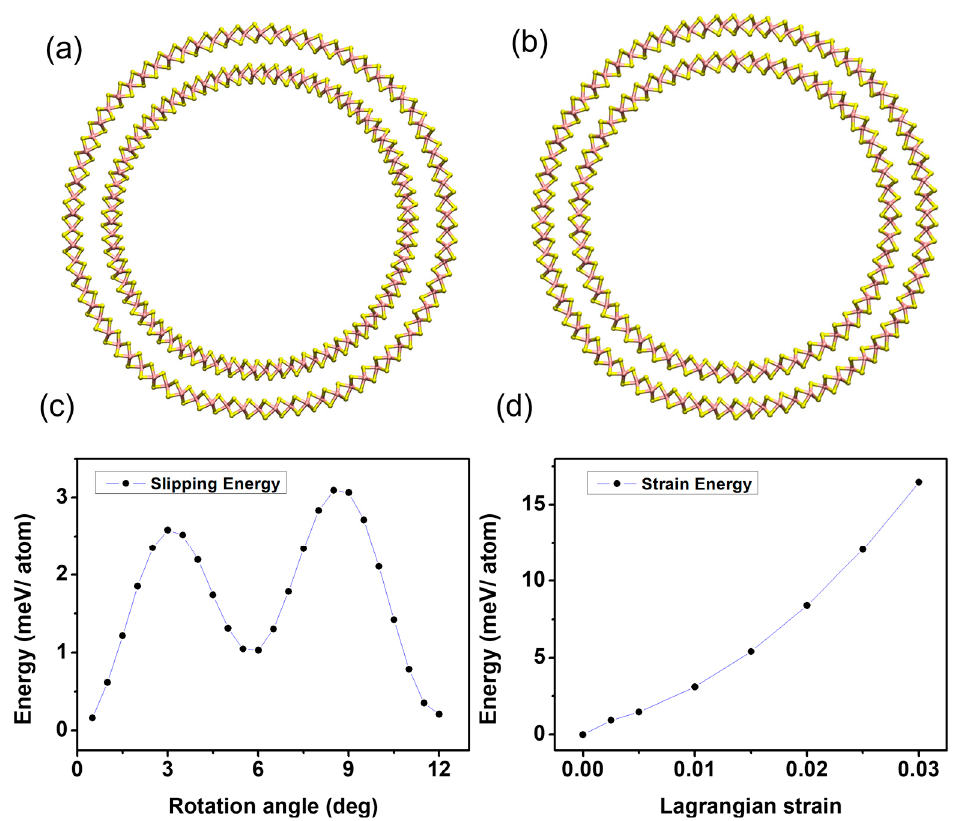
Figure 3. ( a ) Double-walled zig-zag nanotube used to model the high-curvature regions in a hypothetical strained configuration preserving the bulk A-B-C arrangement for both the internal and external layer made of 30-unit cells. ( b ) Double-walled nanotube used to model the high-curvature in an unstrained configuration, breaking the registry between the inner and outer layer. The inner wall counts 30 unit cells while the outer one 37. ( c ) Slipping energy obtained by rotating the inner wall of the model described in ( b ) keeping the outer wall fixed. ( d ) Strain energy computed by expanding the isolated 30-unit-cell inner nanotube.